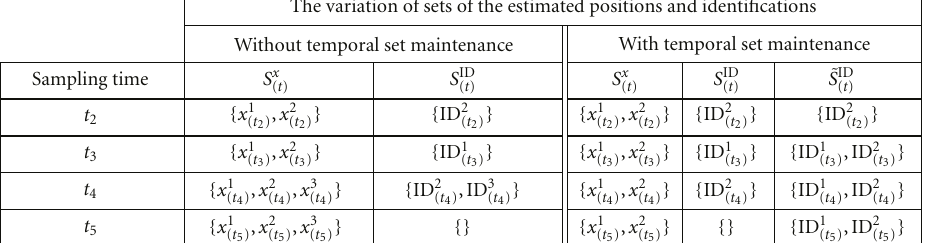
Figure 4: Illustration of a case in which group association is not established by the registration uncertainty of identifications.